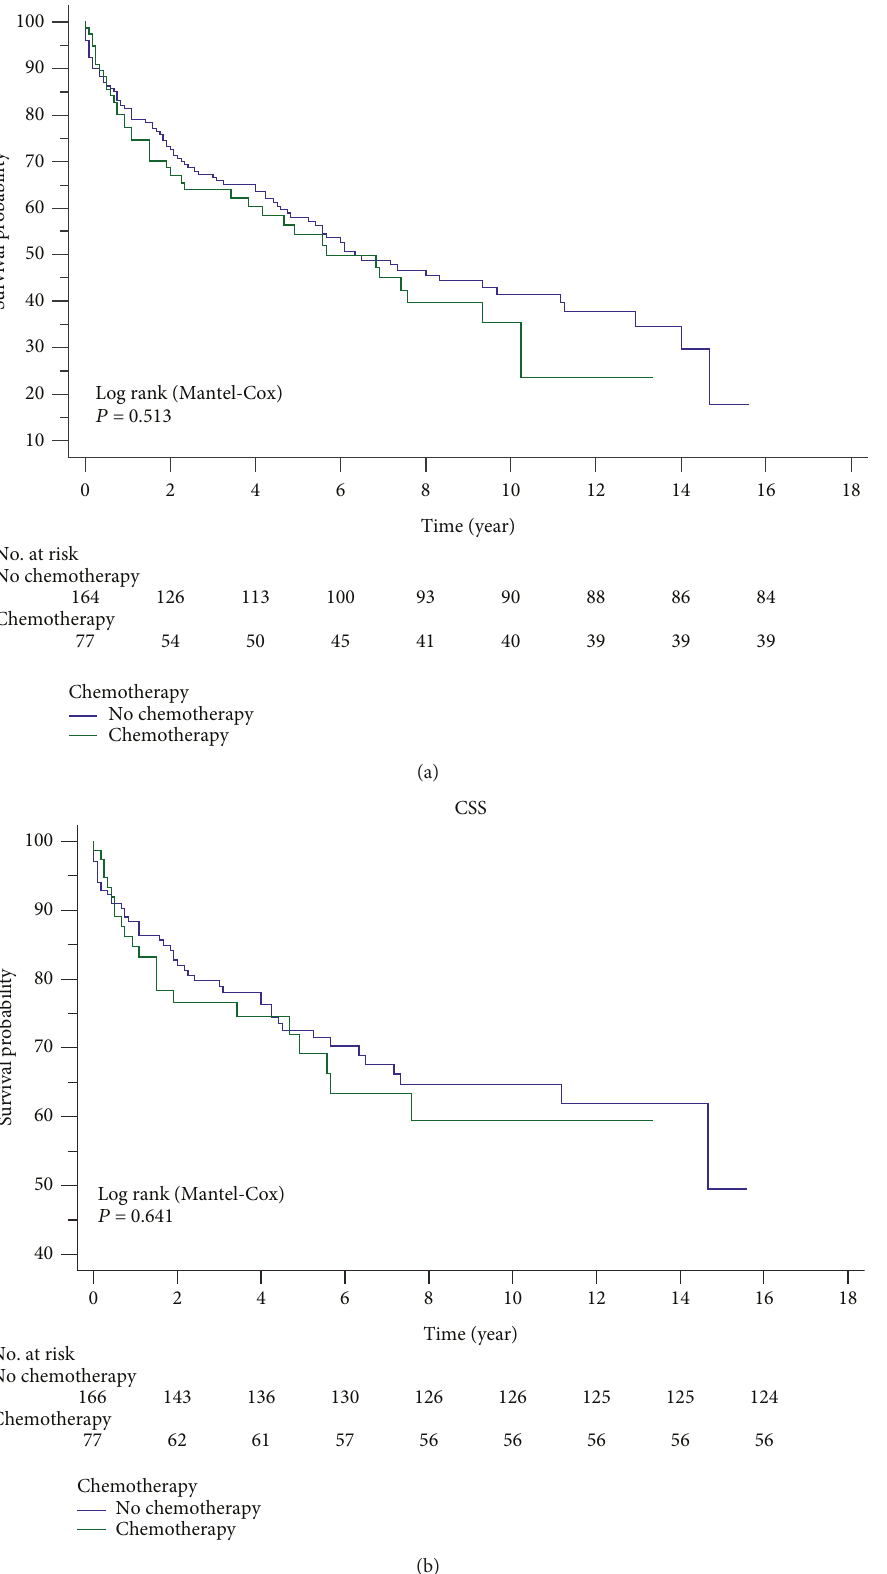
Figure 4: Chemotherapy did not improve the OS and CSS rates via Kaplan-Meier analysis of colonic